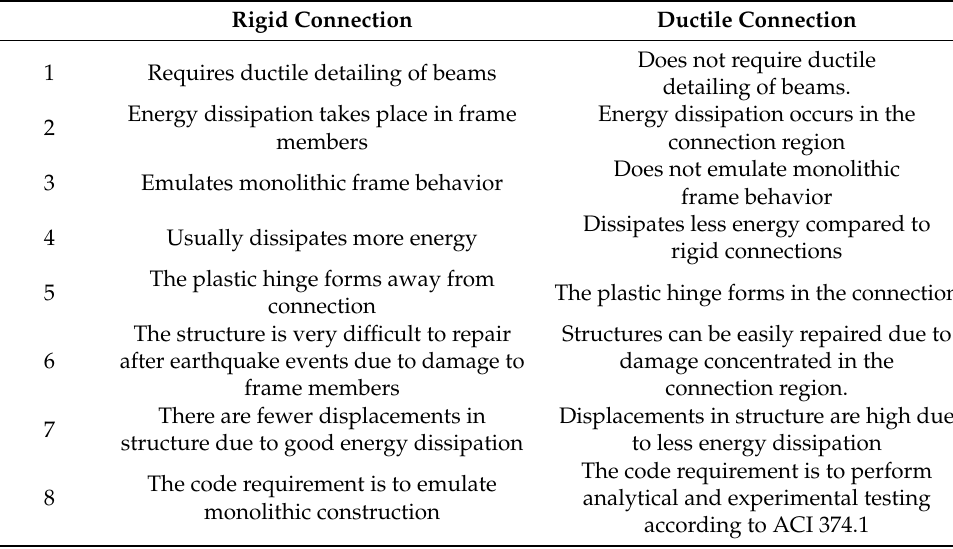
Table 1. Comparison of Rigid and Ductile Connections. Rigid